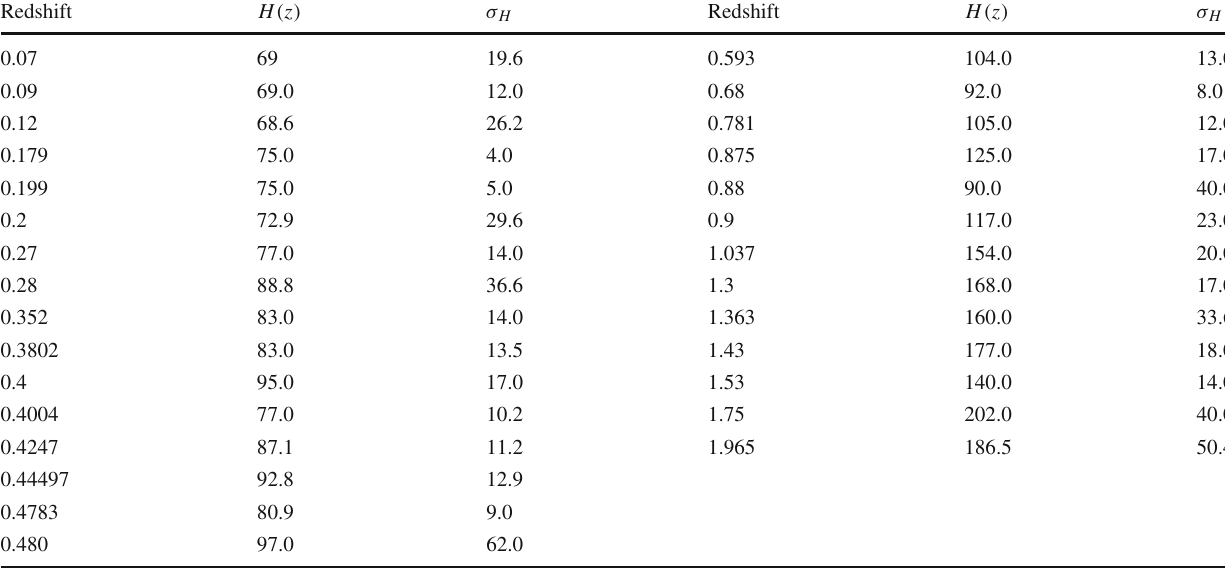
Table 1 A compilation of 31 datapoints of the Hubble function H ( z ) data used in the current analysis as shown in Table 2 of [40]. The relative error points are denoted by the σ H column.